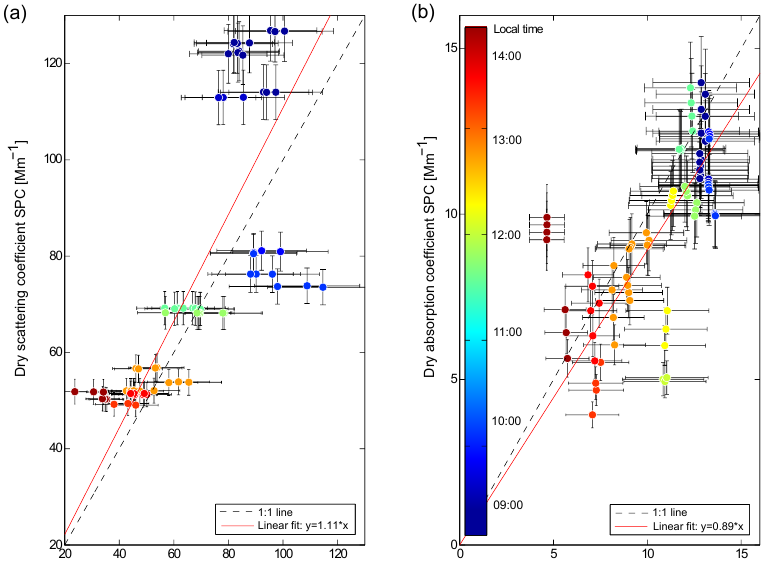
Figure 5. Comparison of dry scattering (a) and absorption (b) coefficients for ground-based and airborne measurements. The Zeppelin results were restricted to altitudes below 150m in order to eliminate differences due to potential changes in atmospheric layers. The colours of the symbols reflect the time of the day according to the colour bar in (b) . Additionally, the regression curves and equations are shown. (a) For the ground-based data an uncertainty of 5% is estimated while ∼ 18% was found for the airborne calculations. (b) The uncertainty of the airborne absorption coefficients is estimated to be ± 20%, while ± 13% is estimated for the ground-based